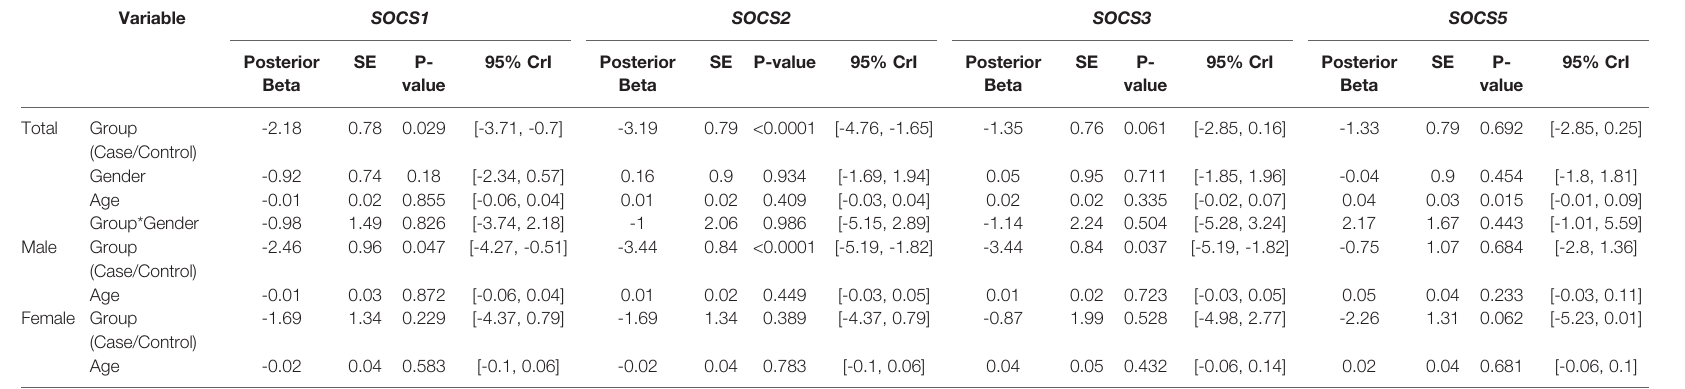
TABLE 3 | Relative expression of SOCS genes in patients and controls.